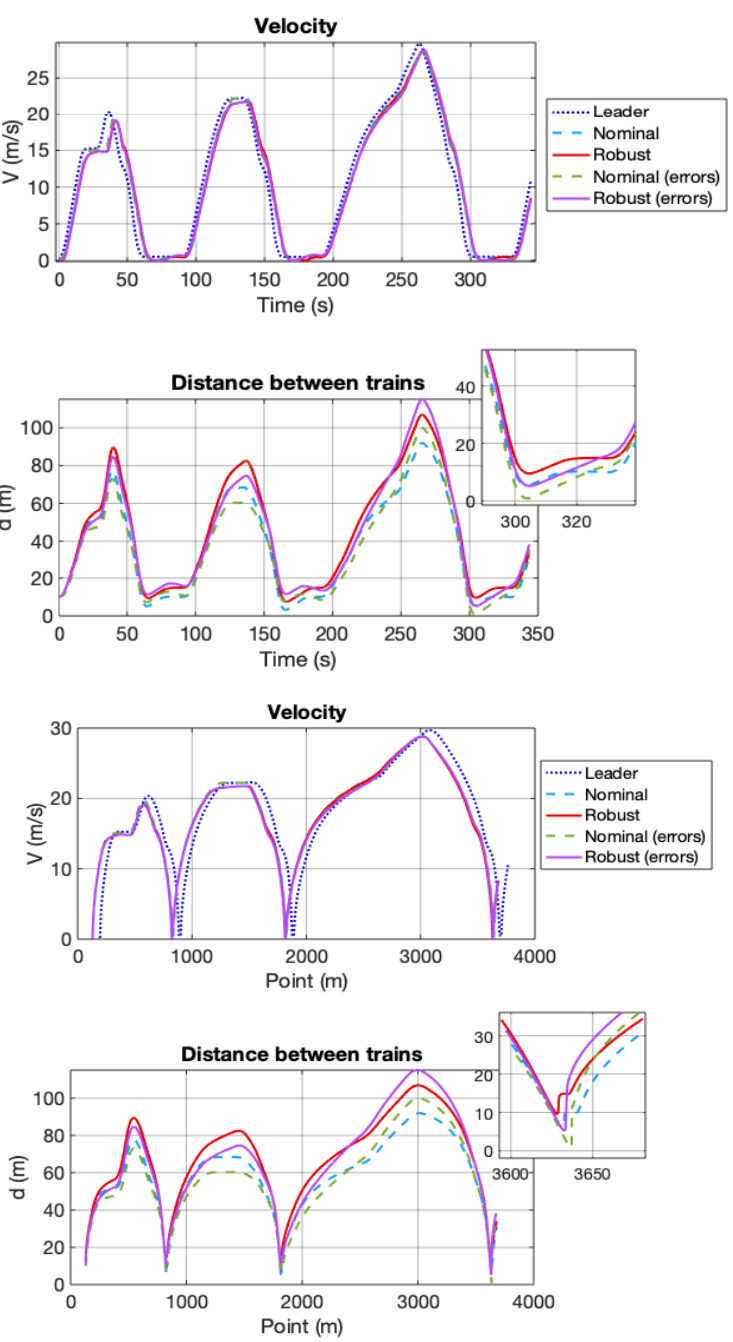
Figure 7. Simulation results 2: Errors in the preceding train information.